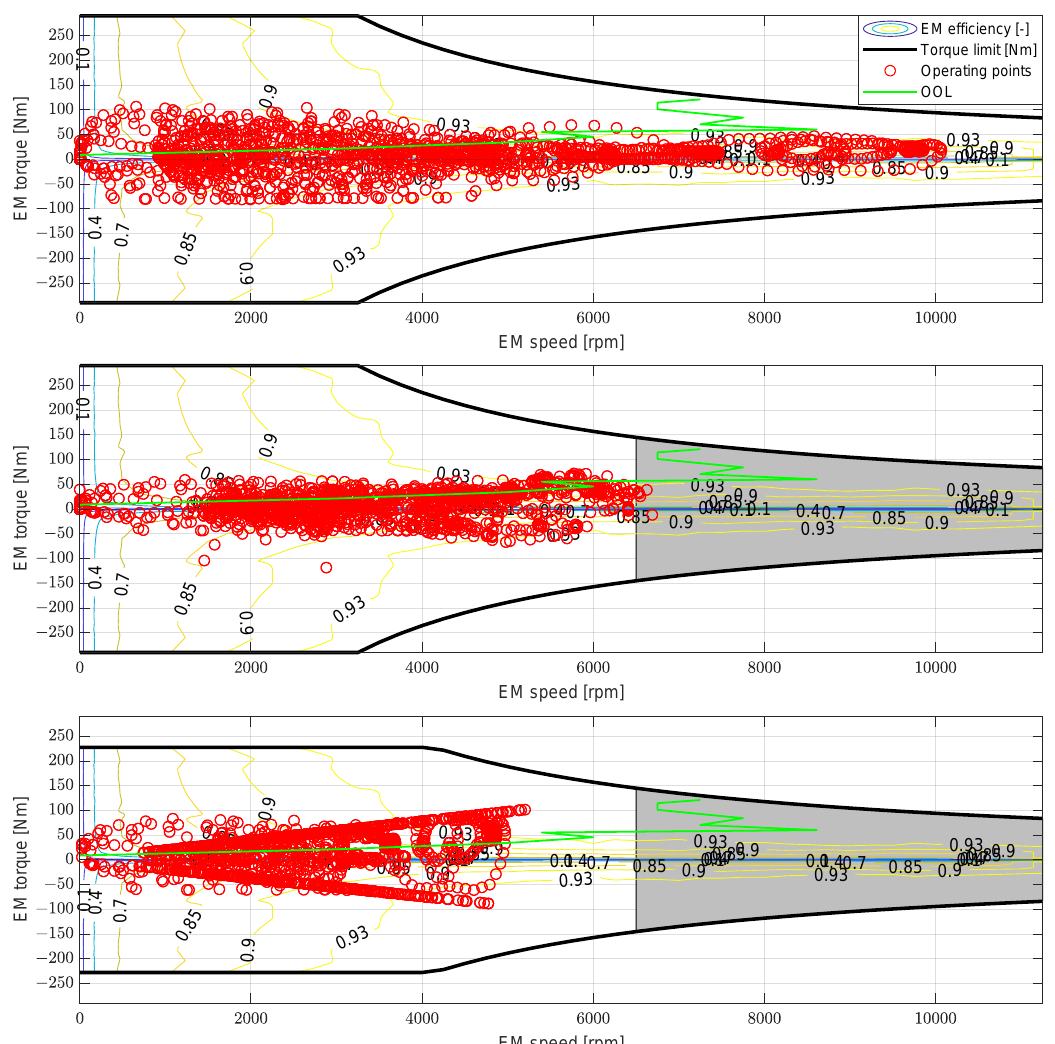
Figure 13. EM operating points on the Worldwide Harmonized Light Vehicles Test Cycles (WLTC). ( Top to bottom ) S 1 , S 2 , and S 3